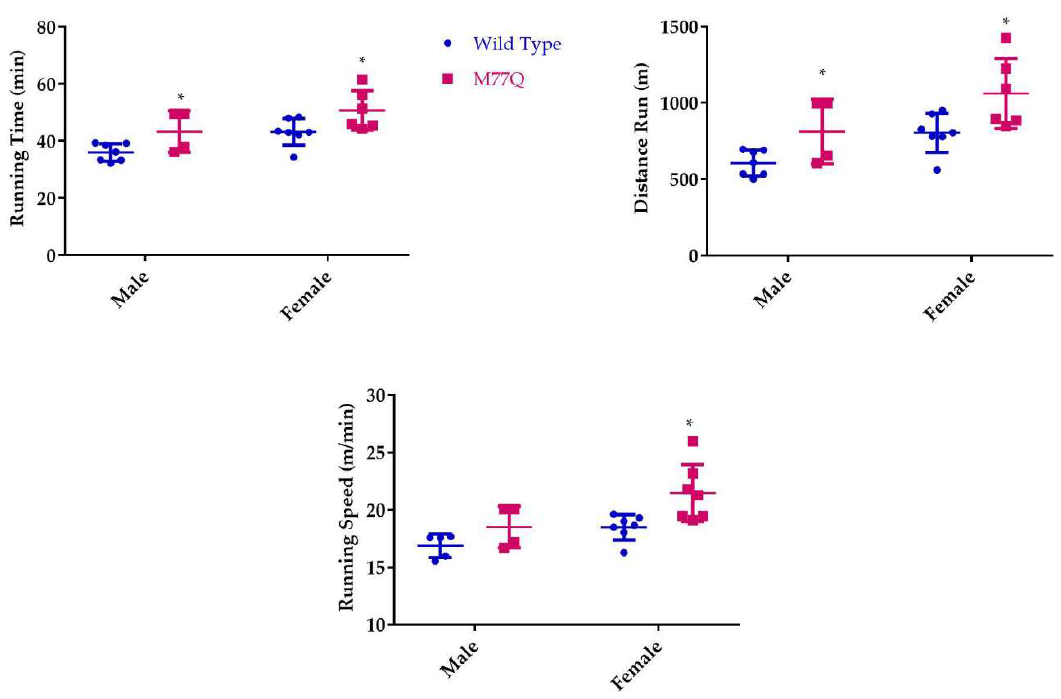
Figure 6. Cardiac parameters during high dose dobutamine stress test at 6 months of age. Except for the female heart rates ( p = 0.05), none of the comparisons were statistically significantly different.